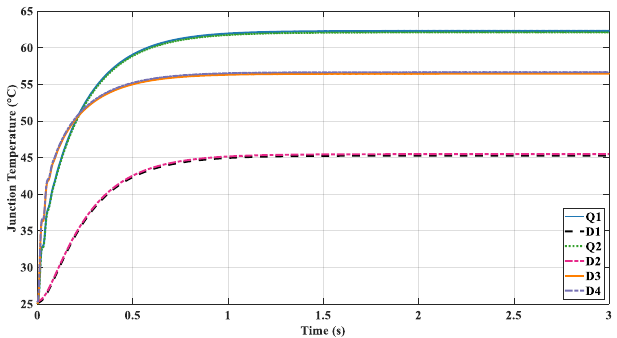
Figure 12. The junction temperature of the power semiconductors within the interleaved boost con- verter.